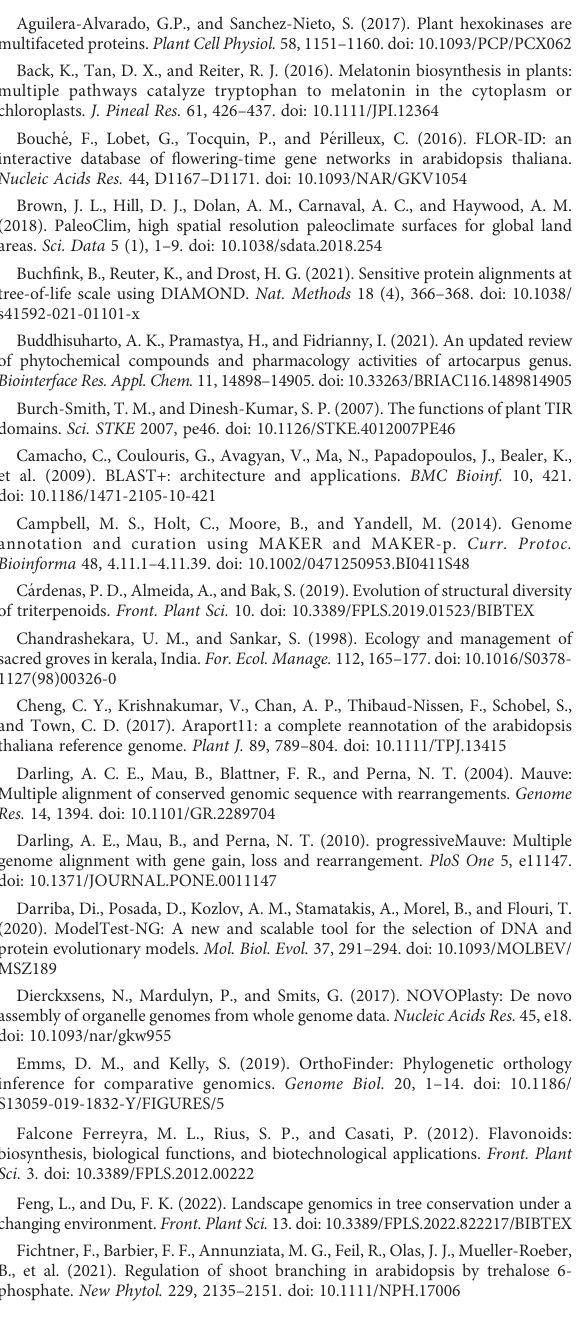
SUPPLEMENTARY FIGURE 3 The phylogenetic relationship between gene copies of the Lectin gene family Receptor Kinase 3 (RK3). Gene copies of Artocarpus hirsutus are coloured in green, A. heterophyllus in blue, and A. altilis in red. SUPPLEMENTARY FIGURE 4 Phylogenetic relationship between gene copies of ASMT and COMT gene families. The sky blue coloured cluster of genes is the COMT